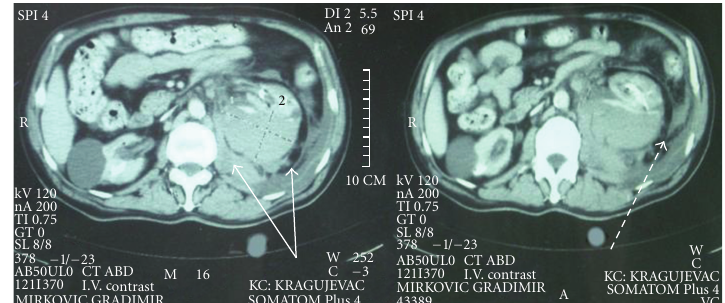
Figure 1: Hematoma diameter 80 × 55mm (solid line), a small amount of perirenal fluid (interrupted line), liquid content in the level pararenal space.